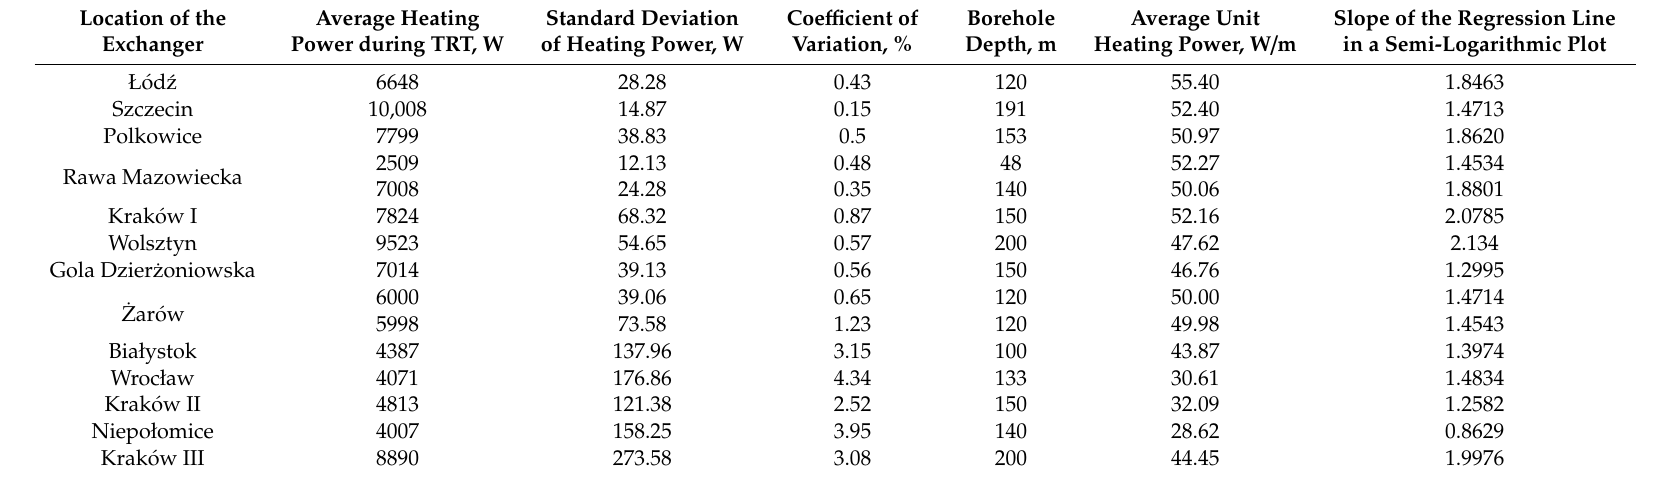
Table 6. Parameters of the tested exchangers, with the interval of every 10